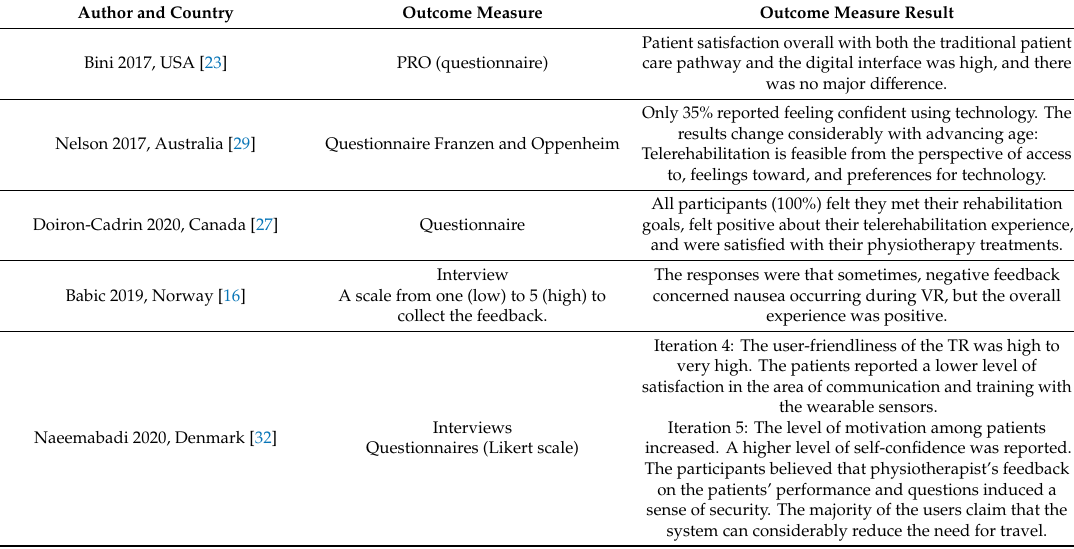
Table 4. Qualitative